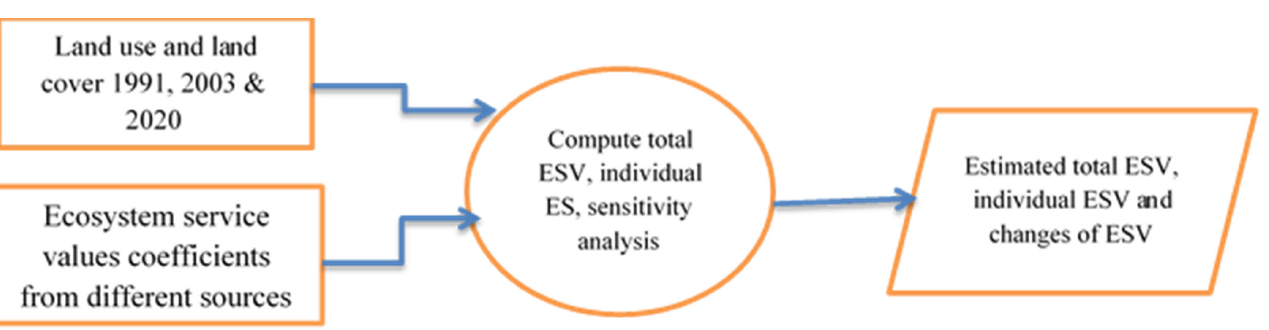
the rate at which LULC varies throughout